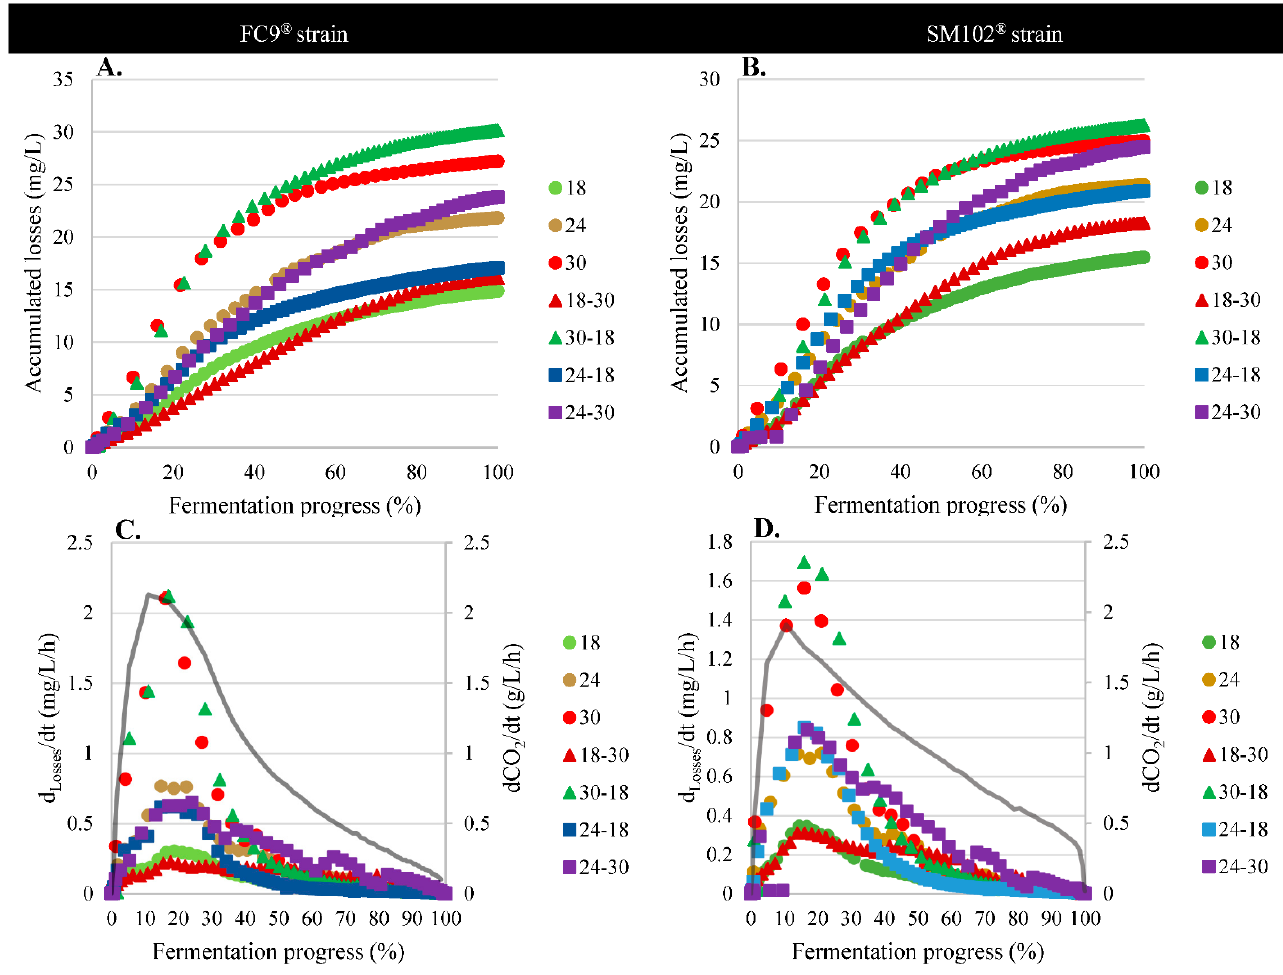
Figure 8. Monitoring of acetaldehyde in the gas phase that provides access to ( A , B ) cumulative losses (mg/L) and ( C , D ) loss rates (mg/L/h) for all temperature profiles with the example of a fermentative kinetics (grey) for both strains: ( A , C ) FC9 ® and ( B , D ) SM102 ®